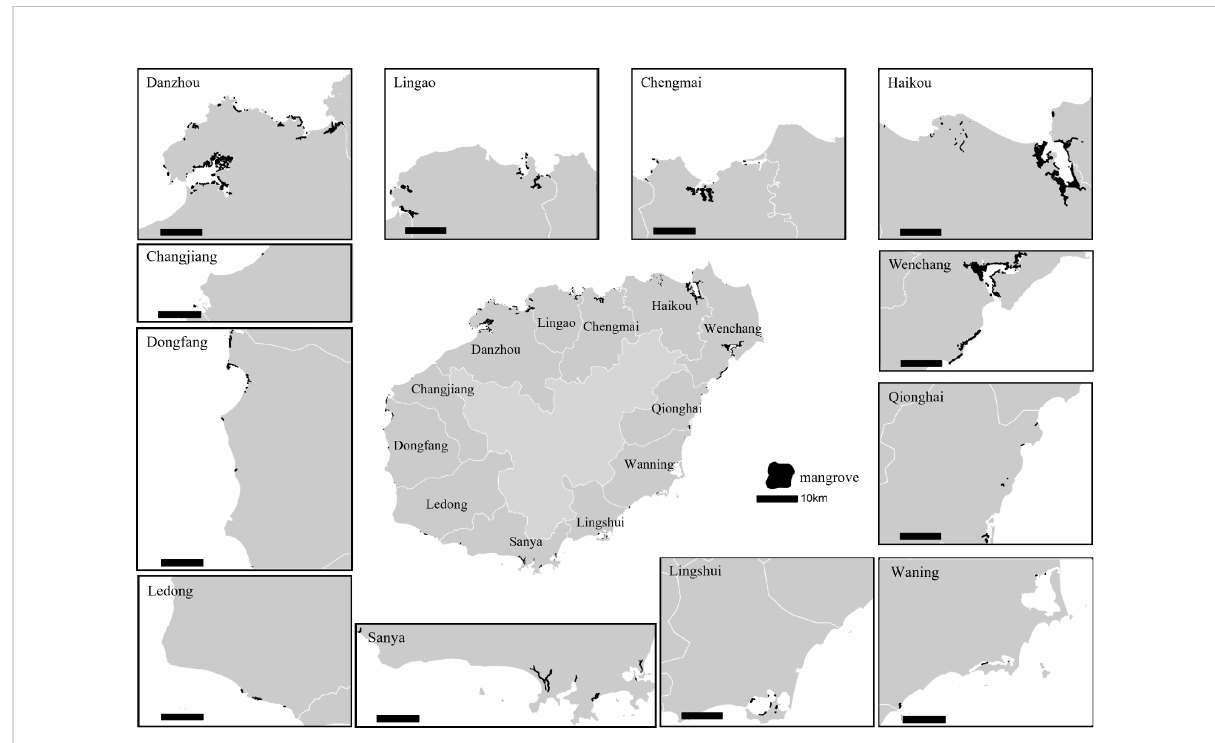
FIGURE 1 Mangrove distribution of Hainan in